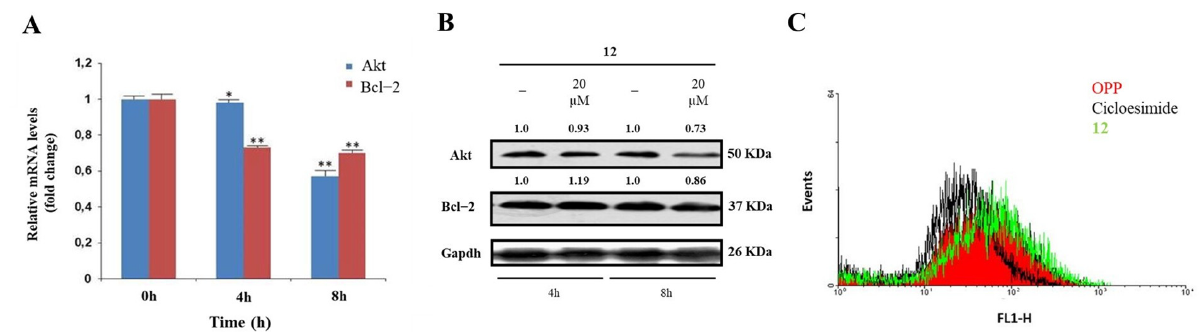
Figure 3. Effects of interaction with compound 12 on hNcl bioactivity. ( A ) Results of real − time PCR of the Akt and Bcl − 2 mRNAs following HeLa cell treatment with compound 12 . * p < 0.05 and ** p < 0.01 vs. time 0 h. ( B ) Western blot analysis of Akt and Bcl − 2. ( C ) Protein neosynthesis in HeLa cells incubated with compound 12 . The numbers shown above the blots are representative of the densitometric analysis after normalization.